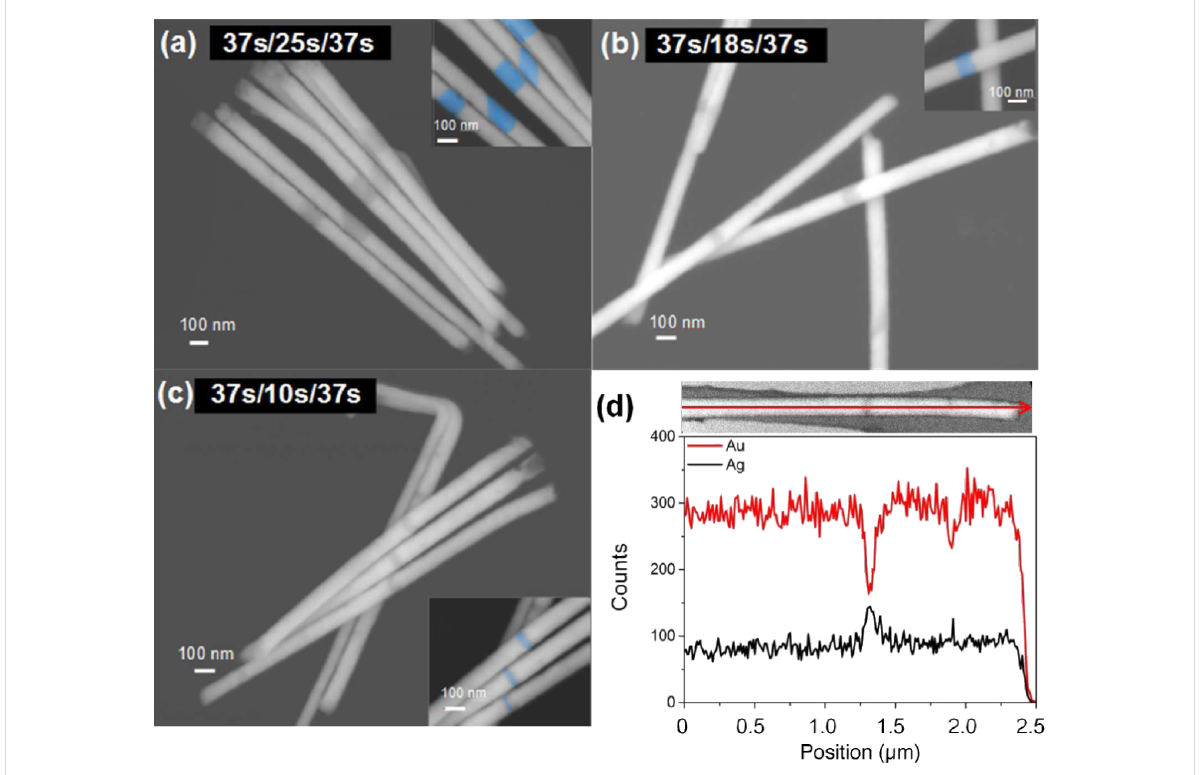
Figure 3: SEM images of Au 60 Ag 40 /Au 15 Ag 85 /Au 60 Ag 40 nanowires similar to Figure 2. The length of the middle pulse is decreased form 25 s (a), to 18 s (b) and 10 s (c). In the insets the Ag-rich segments are marked in blue. (d) EDX scan along a segmented nanowire. The segmented wire is shown in the SEM image on top of the scan. The red and black lines depict the count numbers measured for the Au-M α peak and for the Ag-L α peak, respectively.